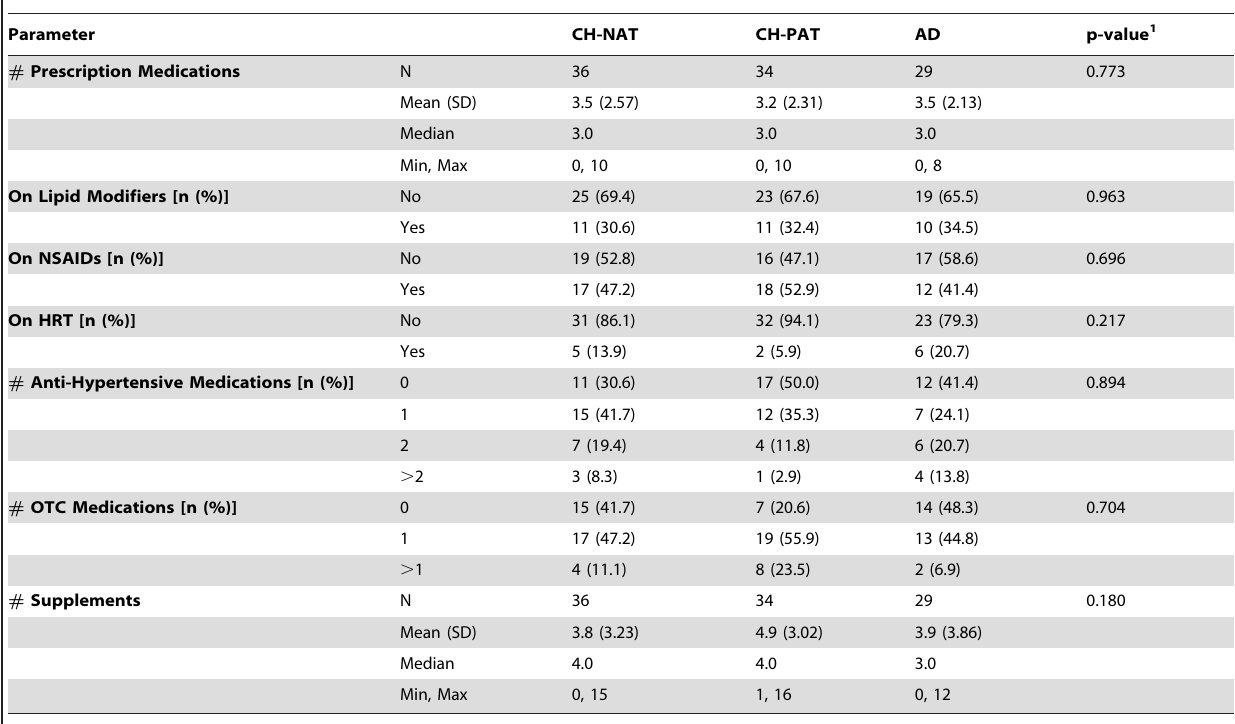
Table 3. Medication and supplement use by clinical group.